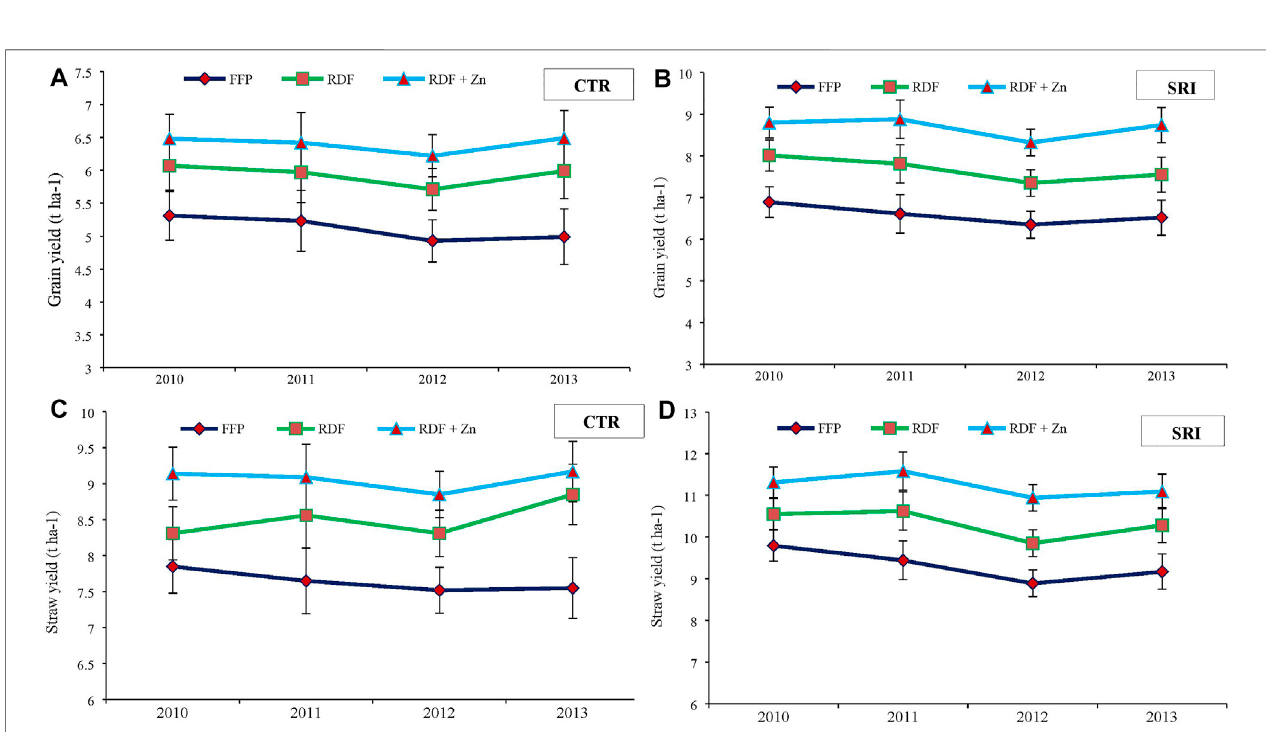
FIGURE 4 | Four years ’ rice grain (A,B) and straw (C,D) yield trend under the CTR vs. NMPs, and SRI vs. NMPs. The vertical bars indicate the LSD at p = 0.05.